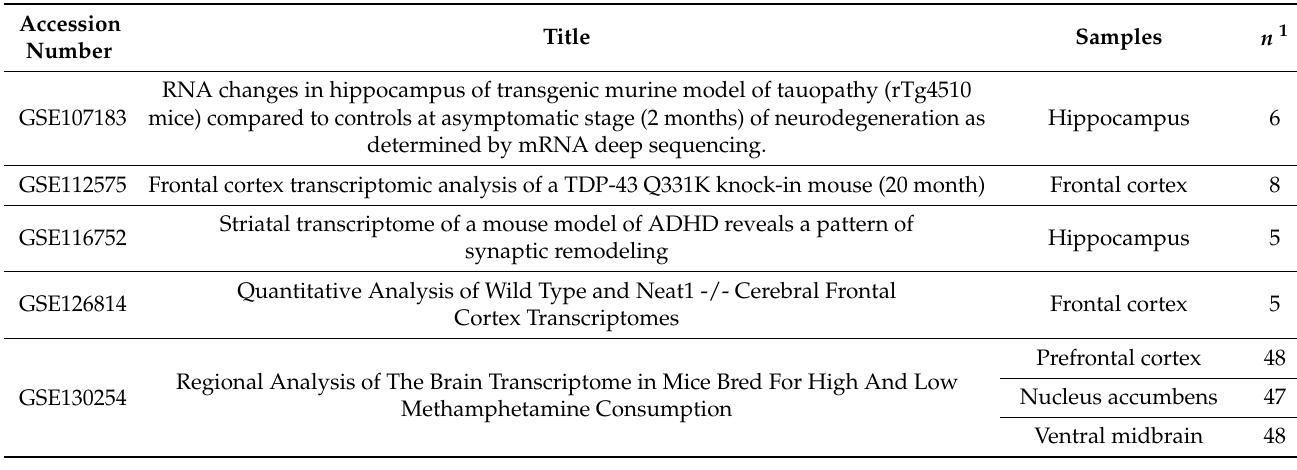
Table 2. Mouse transcriptomic GEO datasets meeting the inclusion criteria and included in the analysis.